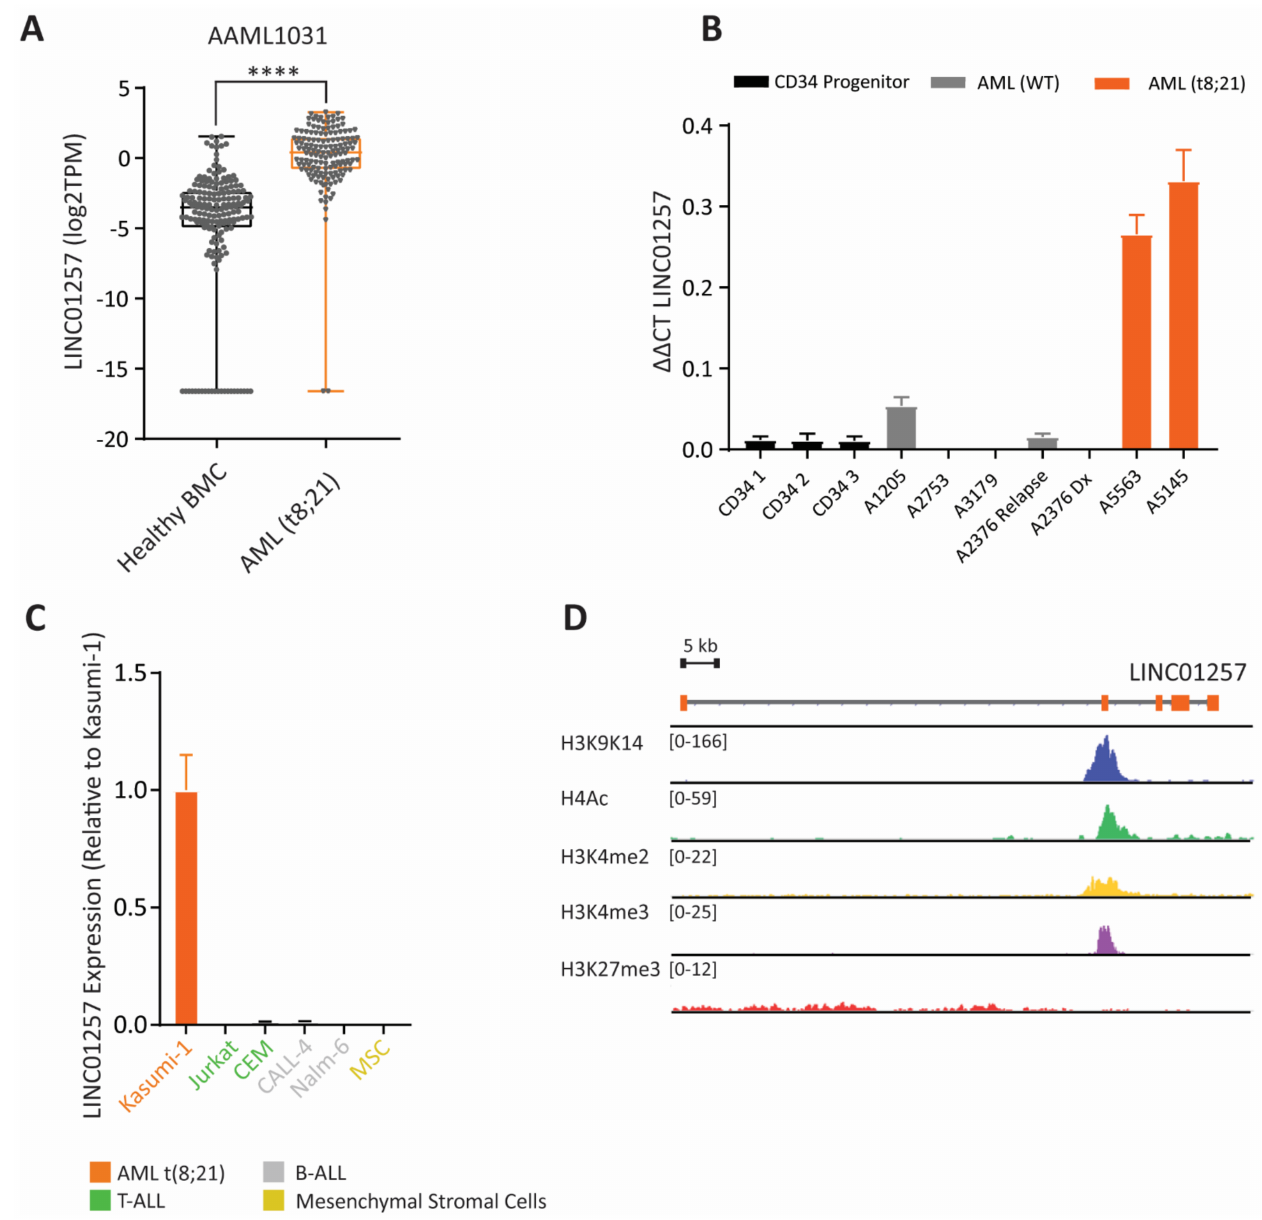
Figure 3. LINC01257 is an AML (t8;21)-specific lncRNA and absent in healthy cells. ( A ) Expression of LINC01257 in healthy bone marrow cells (BMC) and t(8;21) carrying patients from the AAML1031 dataset **** = p < 0.0001. ( B ) RT-qPCR analysis of LINC01257 expression in healthy CD34+ cells and AML patient samples with no fusion (WT) and t(8;21). n = 3. ( C ) RT-qPCR analysis of LINC01257 expression across a panel of cancer cell lines. t(8;21) positive cell line highlighted in orange. n = 3. ( D ) ChIP-seq analysis of histone modification marks in Kasumi-1 cells at the LINC01257